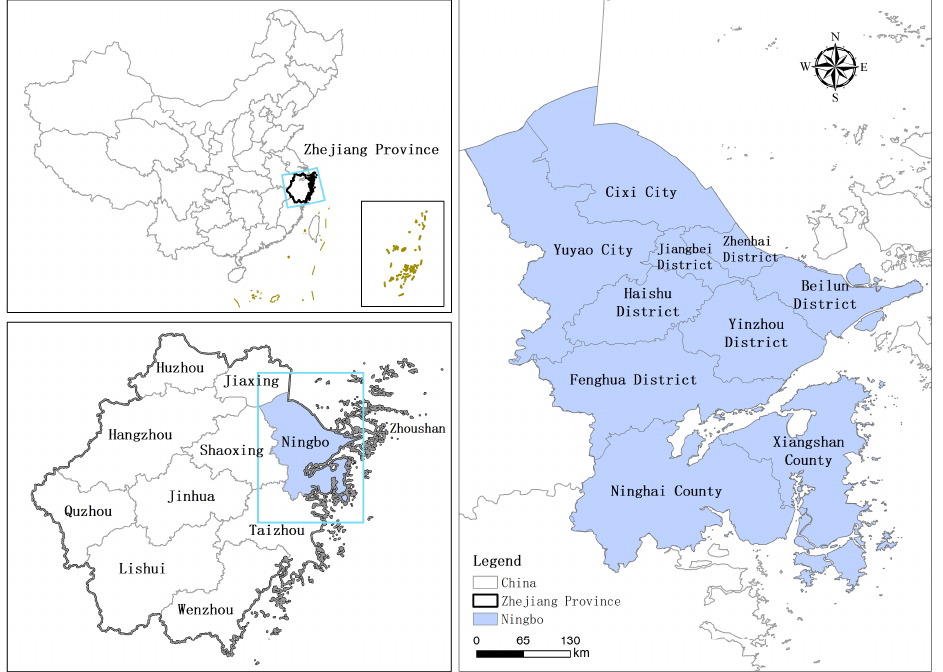
Figure 1. Research location map.